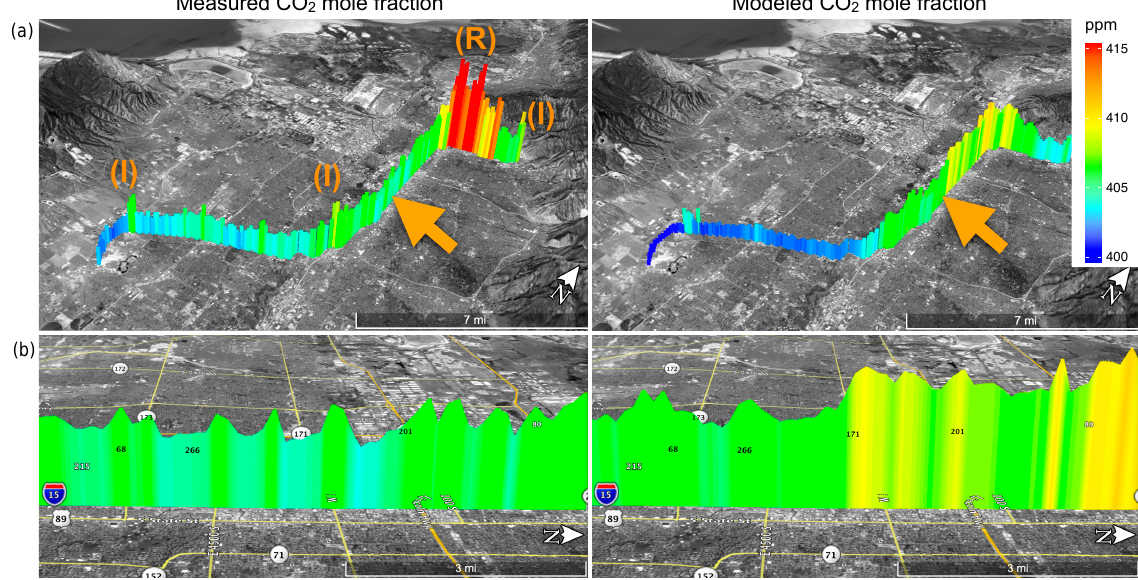
Figure 7. Key differences between measured and modeled tracer mole fraction occur near HNF sources, including passing large roadways and intersections (I) and where the light-rail track is shared by other vehicles on the roadway (R). The orange arrow indicates the viewpoint of the bottom panels. The model captures the overall urban–suburban–rural CO 2 mole fraction gradient (a) as well as localized enhancements near grid cells containing large emitters such as busy roads (b) . Map data: Google,